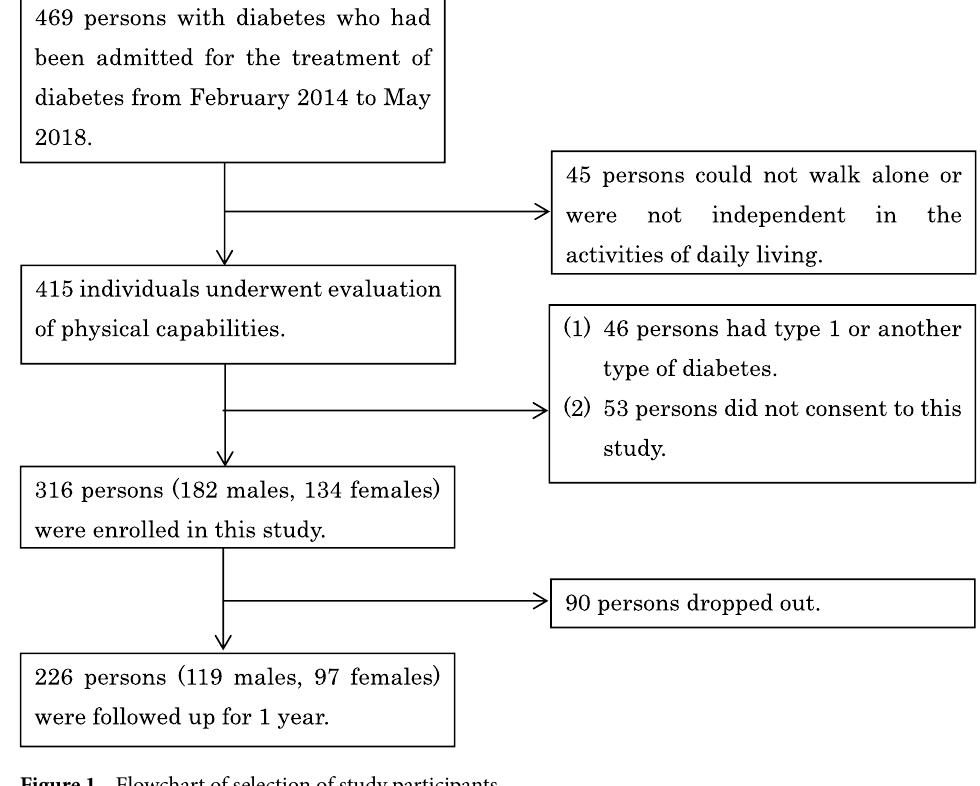
Figure 1. Flowchart of selection of study